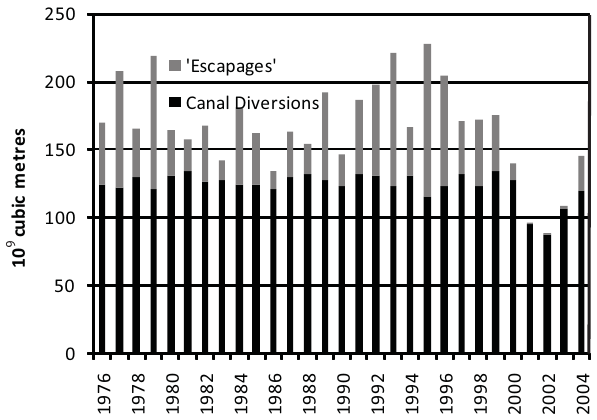
Fig. 2. Annual canal withdrawals and “escapages” to the sea (After Fig. 2 Annual canal withdrawals and ‘escapages’ to the sea (After Briscoe and Qamar, 2007) 738 Briscoe and Qamar,